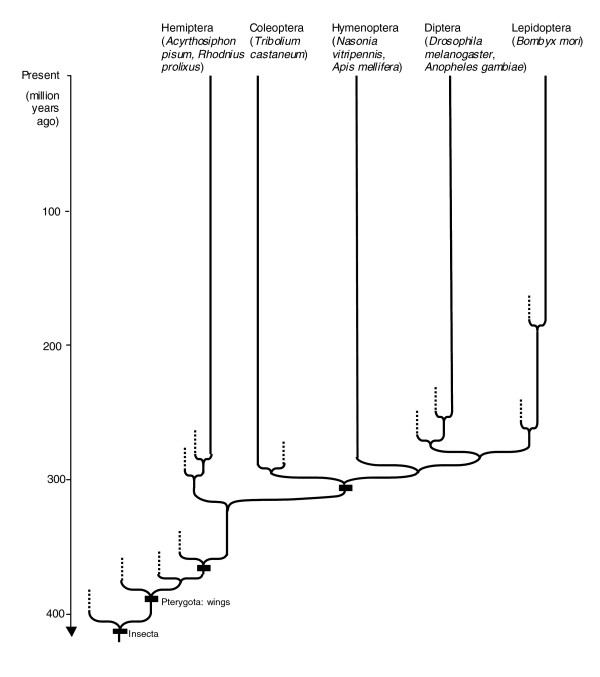
Schematic phylogenetic tree representing the insect Orders comprising species where genome sequencing projects have been completed or are in an advanced stage. The figure is a greatly simplified version of a phylogeny shown in [9] representing the largely agreed relationships between these Orders, plus the major evolutionary transitions for insects (as deduced by synamorphic characters, that is, novel characters derived from preexisting ones) along a time scale expressed in millions of years from present. For each Order with species involved in a genome sequencing project, the node corresponding to its separation from its most closely related order (extant or extinct) is shown (dashed lines represent sister clades).